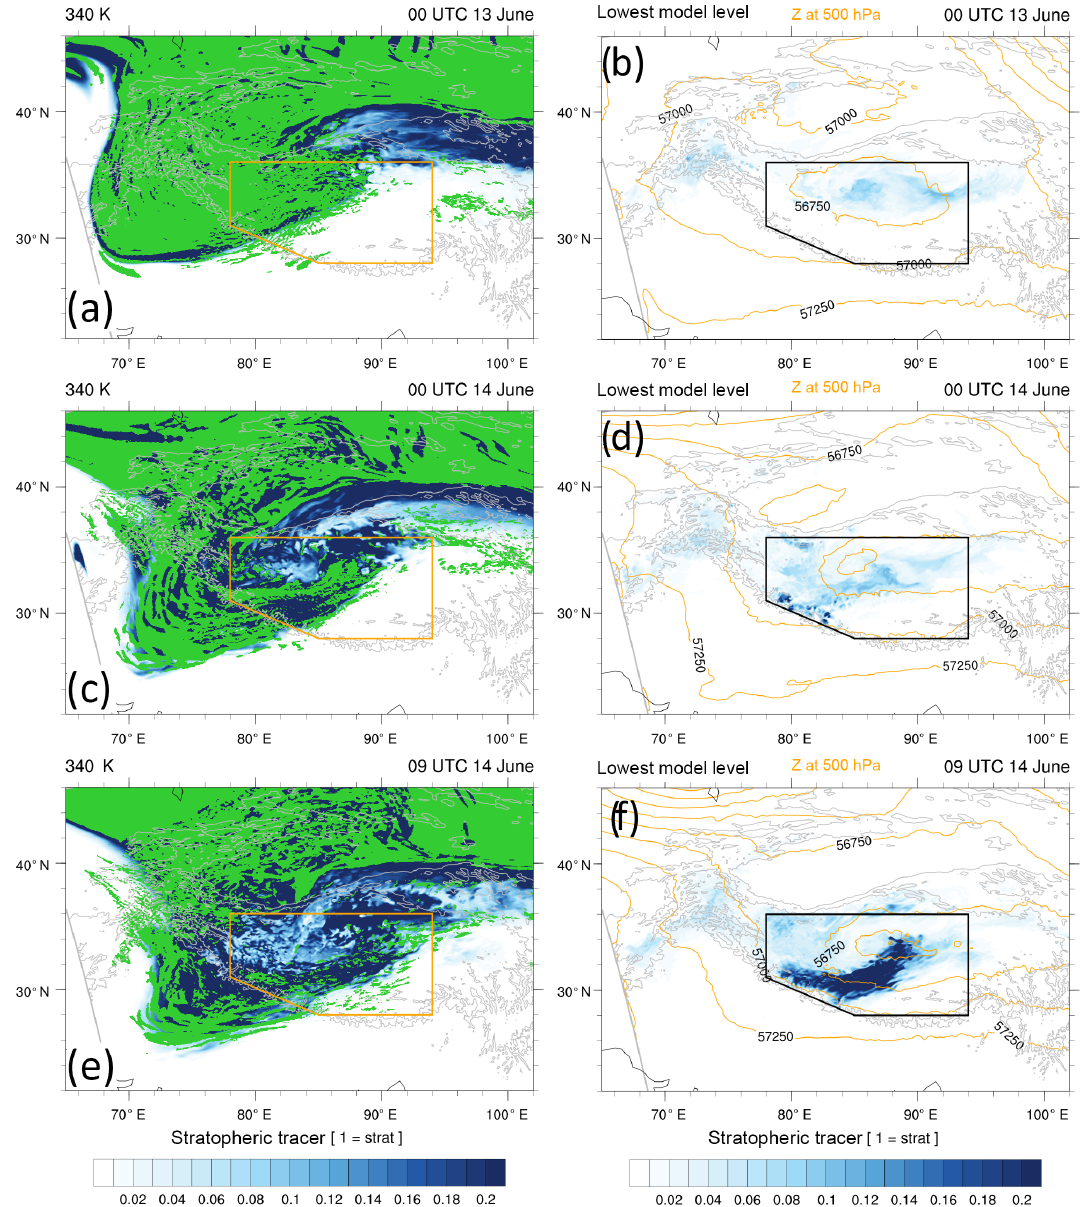
Figure 6. Concentration of stratospheric tracer (blue colours up to values of 0.2; green shows values larger than 0.5) on the 340K isentrope (left) at (a) 00:00UTC on 13 June, (c) 00:00UTC on 14 June and (e) 09:00UTC on 14 June 2006 (as in Fig. 5) and (right) on the lowest model level at the same times. Additionally, the geopotential height at 500hPa is shown with orange contours (contour interval 250m) in panels (b) , (d) and (f)